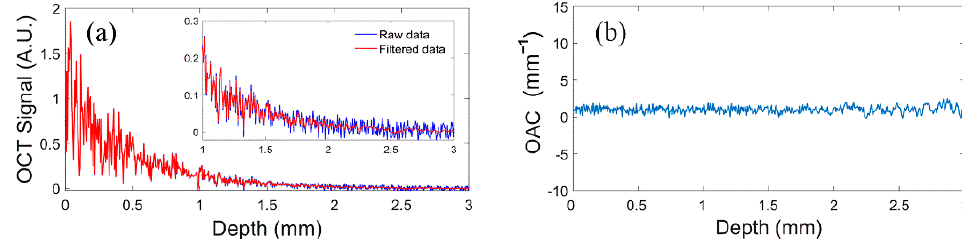
Figure 4. ( a ) The Kalman fi lter result of the numerical simulation in Figure 2c; the blue curve repre- sents the signal after subtracting the mean of the noise fl oor and the red curve represents the fi ltered signal. ( b ) The corresponding OAC calculated from the fi ltered data.